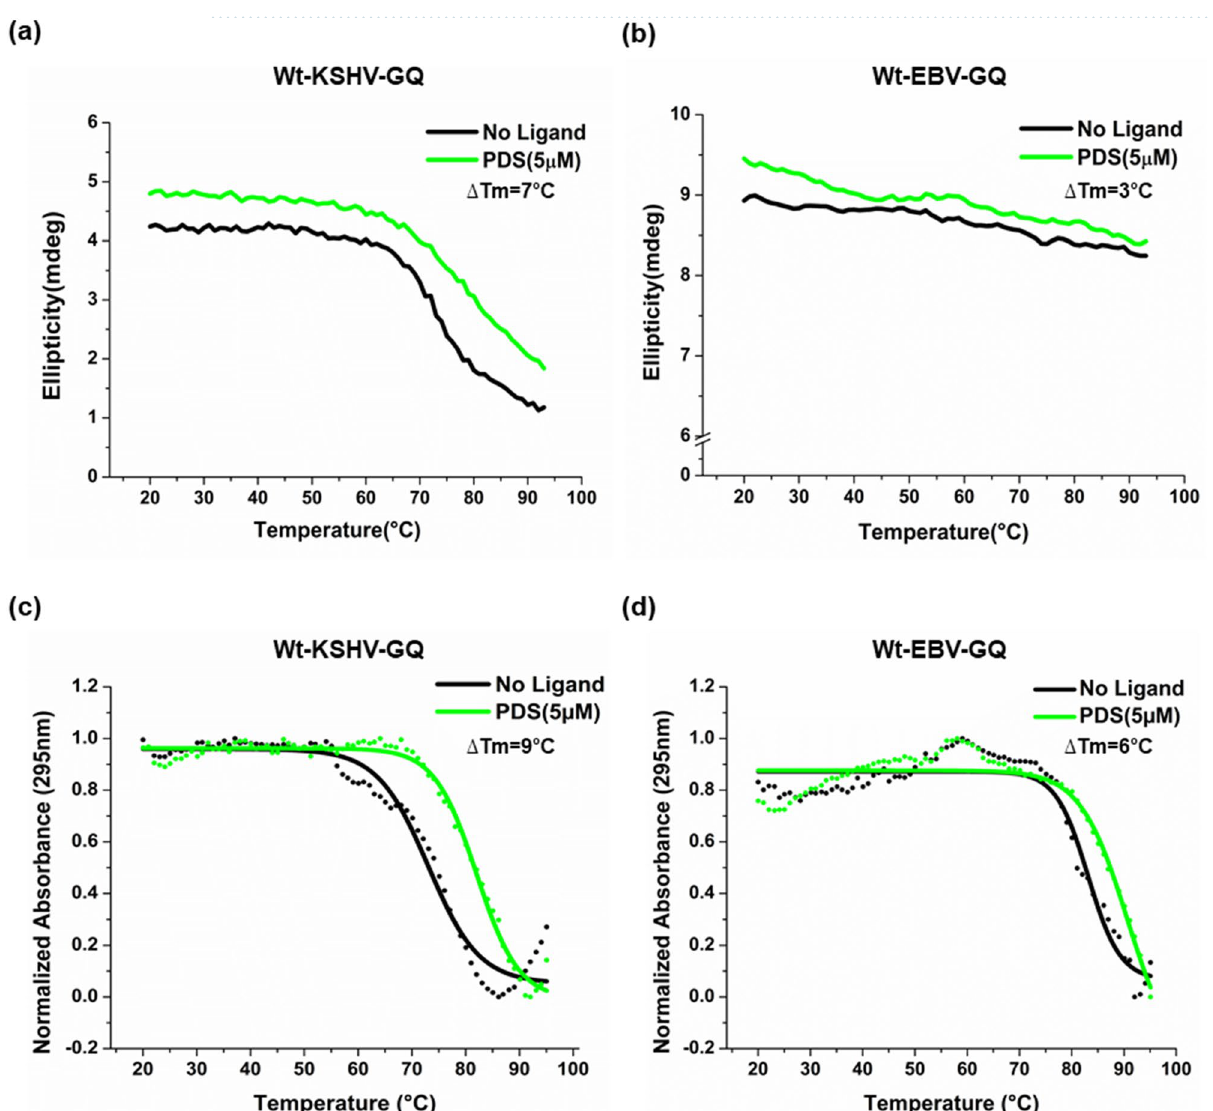
Figure 3. Biophysical analyses of KSHV-GQ and EBV-GQ reveals formation of stable intramolecular G-quadruplex in vitro. ( a ) CD spectra of Wt-KSHV-GQ and Wt-EBV-GQ show formation of hybrid (mixed type) and parallel G-quadruplex structures, respectively. Mutations were introduced to disrupt the G-quadruplex (Mut-KSHV-GQ and Mut-EBV-GQ). As expected, the mutant oligonucleotides did not form G-quadruplexes. ( b ) Native and denaturing polyacrylamide gel electrophoresis experiments reveal formation of intramolecular secondary structures attributed to the higher mobility of wild type oligonucleotides i.e., Wt-KSHV-GQ and Wt-EBV-GQ when compared with that of mutants (Mut-KSHV-GQ and Mut-EBV-GQ) and length match controls that do not form DNA secondary structures. ( c ) 1D 1 H NMR spectra of Wt-KSHV-GQ and Wt-EBV-GQ oligonucleotide show resonance peaks of imino protons between 10.5–12 ppm, confirming the formation of G-quadruplexes. The NMR spectra suggest that Mut-KSHV-GQ and Mut-EBV-GQ do not form G-quadruplexes. ( d ) DMS footprinting experiments using 5’ FAM labelled oligonucleotides Wt-KSHV-GQ and Wt-EBV-GQ show formation of intramolecular G-quadruplex structures. Footprinting experiments were performed using different KCl concentrations {500 mM, 100 mM, and 0 mM (i.e., no KCl)}. AG represents seq uencing cleavage reactions specific to purine residues. The vertical bars next to the sequence of the oligonucleotide represents the G residues protected from DMS methylation due to formation of G-quadruplex structure. It is to be noted that the ladder (AG cleavage reaction lane) of the footprinting gel of Wt-KSHV-GQ has been snipped off from another part of the same gel and aligned together with the quadruplex sequence cleavage reaction lanes for comparison.